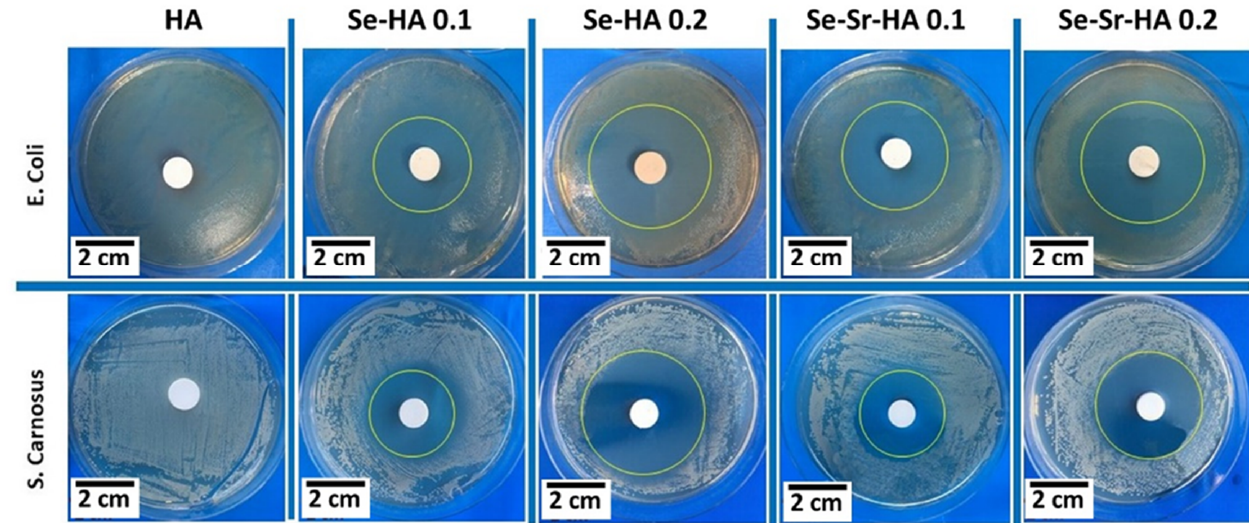
Figure 7. Zone of inhibition test, using disc diffusion assay against Gram-negative ( E. coli ) and Gram-positive ( S. carnosus ) bacteria. The inhibition zones around the Se-Sr-HA discs are clearly shown compared to those of positive control (PC).